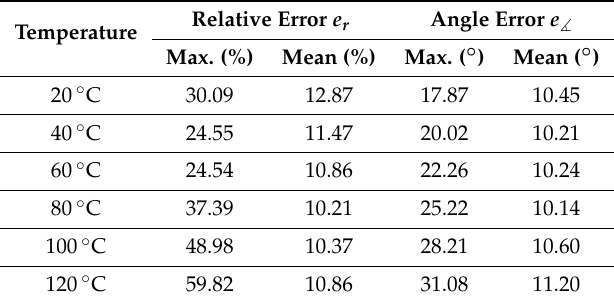
Table 8. Calculated errors by considering the GMR non-linear characteristic at different temperatures.